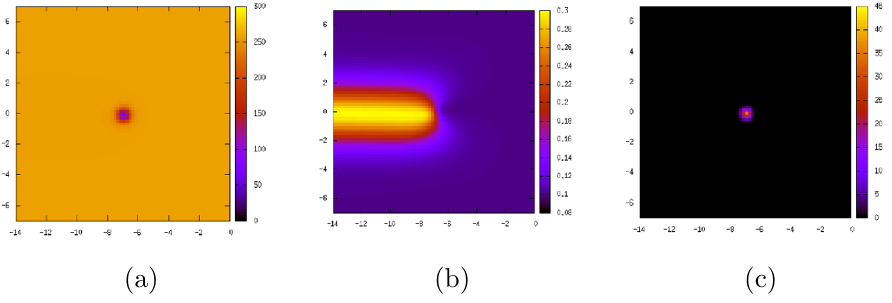
Figure 10 . A full 2D numerical simulation for an Alice string confined by a soliton (figures taken from [59]). (a) The gauge invariant 4 Tr Φ 2 Tr Φ † 2 ∼ ξ 4 f ( r ) 2 g ( r ) 2 vanishing at the center of the Alice string. (b) The interaction potential V (1) + 2 ξm 2 , in which the domain wall is clearly visible. int λ ψ